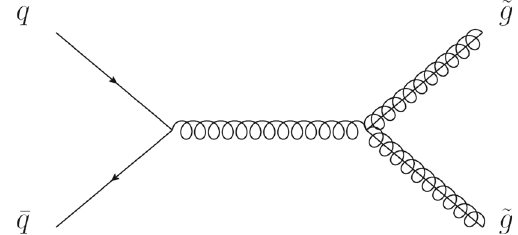
Fig. 61 Feynman diagram of gluino pair production by quark annihi-